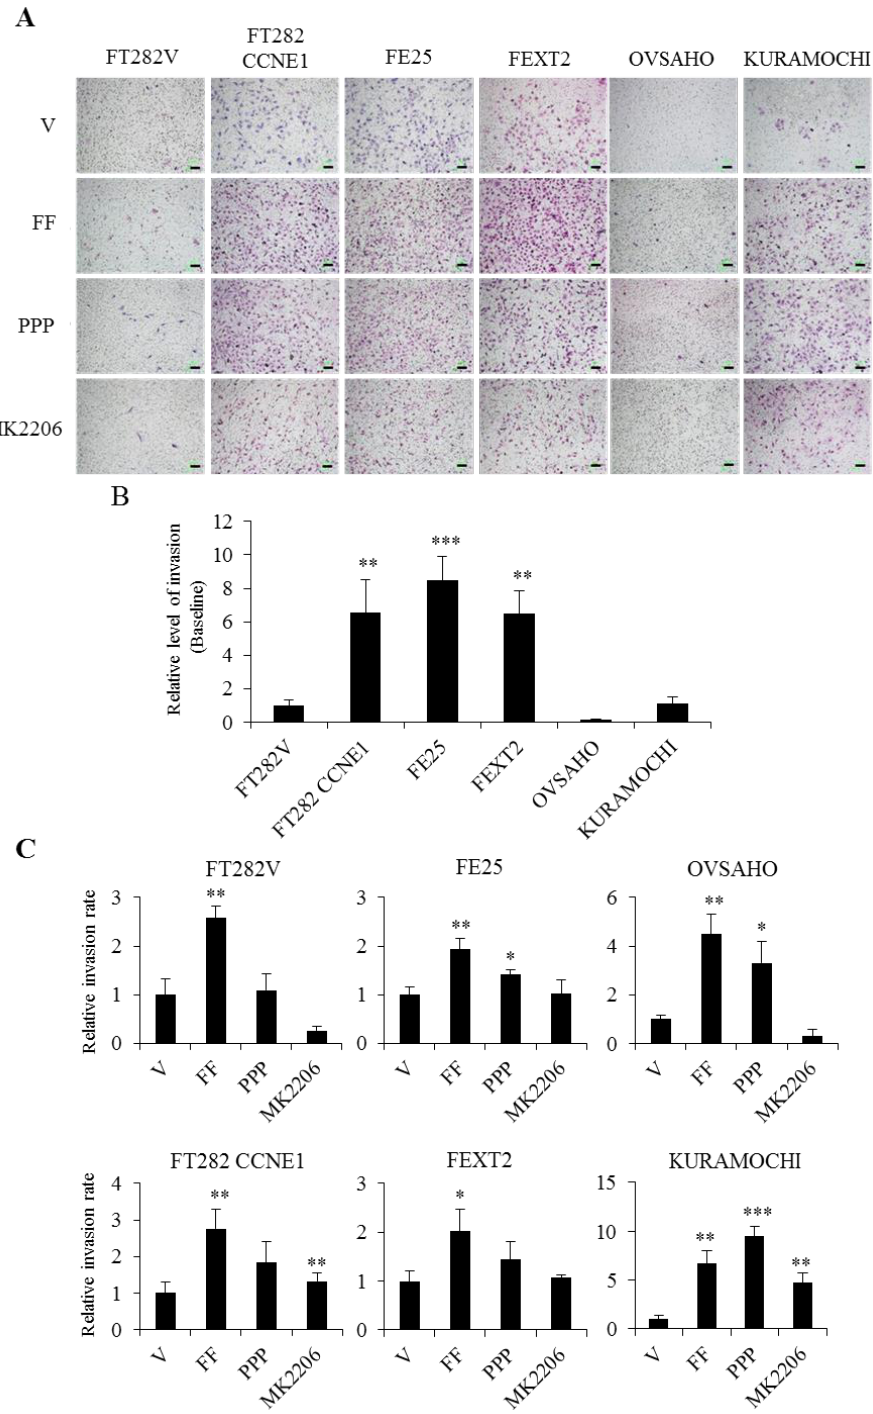
Figure 7. FF highly promotes the invasion of FTE /HGSC cells, largely by AKT signaling. Transwell invasion assay was conducted using matrigel coated insert with 8 μm pore size. Growth medium with 10% FF or vehicle served as a chemo- attractant in two layers of medium. The same PPP and MK2206 pre-treatment were done for 30 min, and the number of migrated cells per field were imaged and counted at 48 h. ( A ) Representative images of invaded cells for each cell line. Scale bar, 100 μm. ( B ) Baseline value of cell invasion using FT282-V cell line as a reference. ( C ) Comparison of different treatment groups. Data were calculated with mean ± SD from three independent experiments; * p < 0.05, ** p < 0.01, *** p < 0.001 by two-sided, unpaired Student’s t -test.